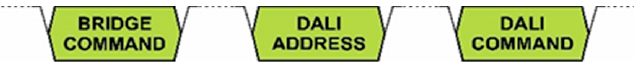
Figure 4. Request frame format.